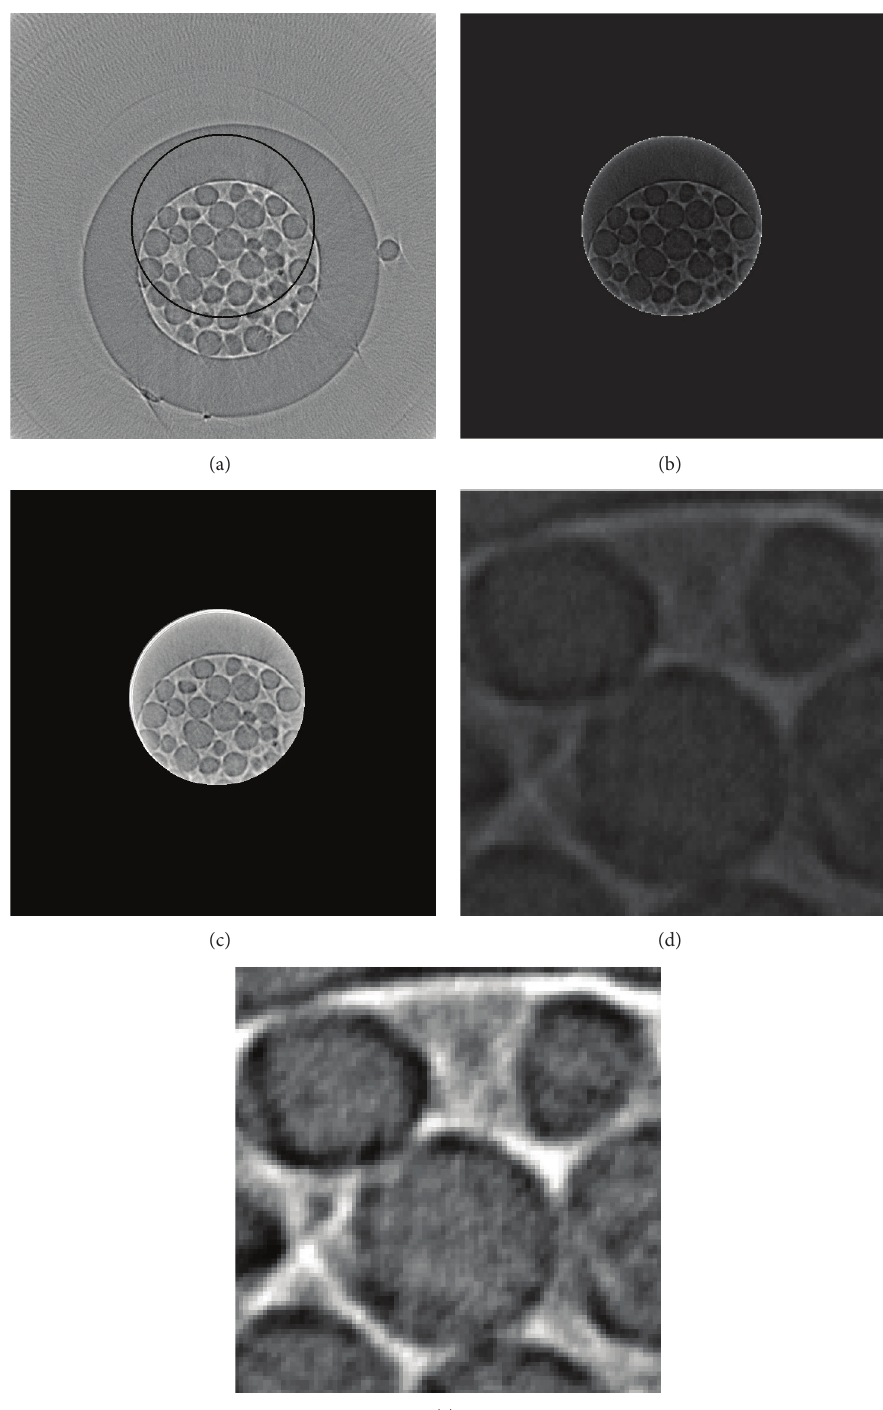
Figure 8: (a) Reconstruction by FBP using global data. (b) Reconstruction by FBP using local data. (c) Reconstruction by the new algorithm using local data. (d) and (e) were the amplifications of (b) and (c),